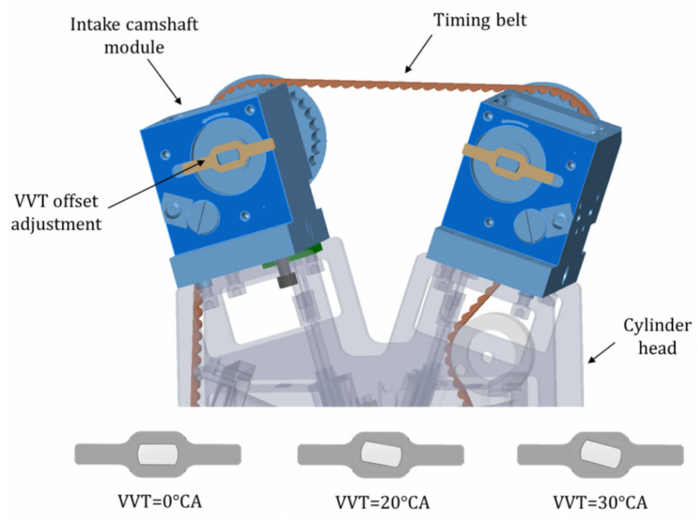
Figure 2. Intake camshaft module—VVT offset adjustment. The VVT offset is given in crank angle degrees ( ◦ CA) in the direction of the valve overlap and varied from 0 to 30 ◦ CA (Figure 3).